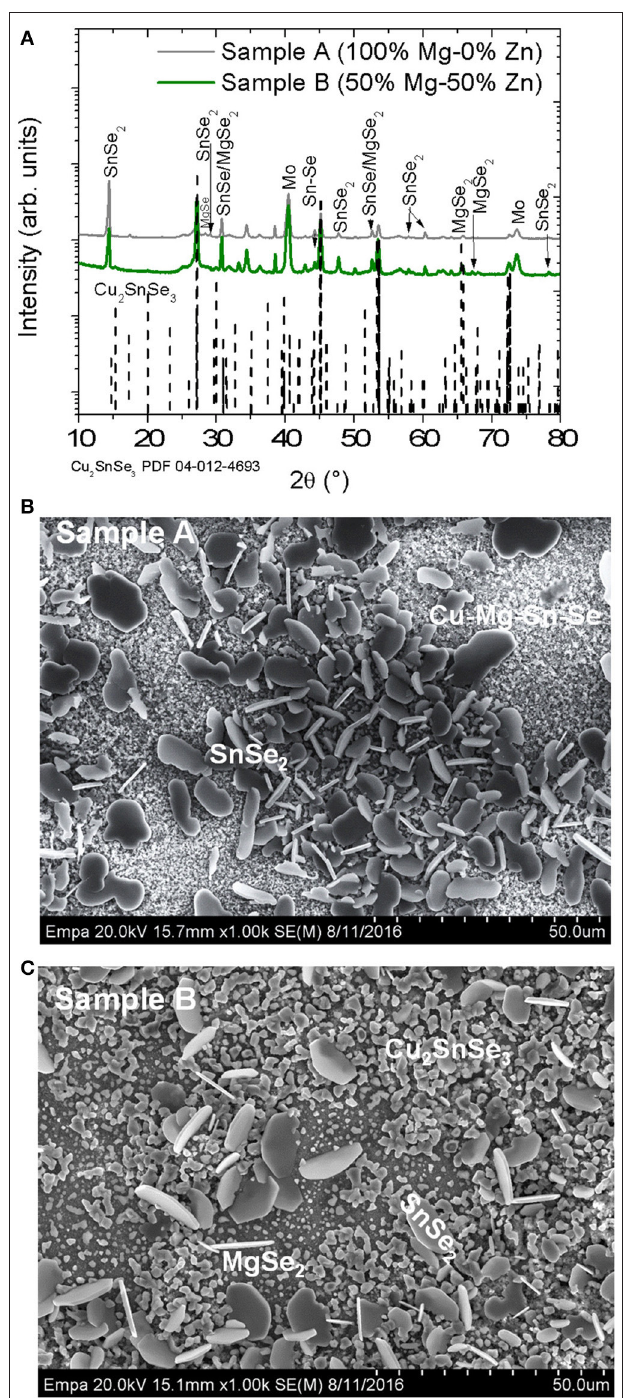
FIGURE 1 | (A) GIXRD patterns of samples A and B exhibiting reflexes of Mo, Cu 2 SnSe 3 , SnSe, SnSe 2 , MgSe, and MgSe 2 . The PDF files number 04-012-4693, 04-009-2277, 01-089-2939, 04-018-3911, and 04-004-2933 have been used to identify Cu 2 SnSe 3, SnSe, SnSe 2 , MgSe, and MgSe 2 phases respectively. The dashed lines correspond to Cu 2 SnS 3 phase. (B,C) Surface morphology of the samples A and B respectively. Different grains are formed, which are characteristic of the different secondary phases identified by